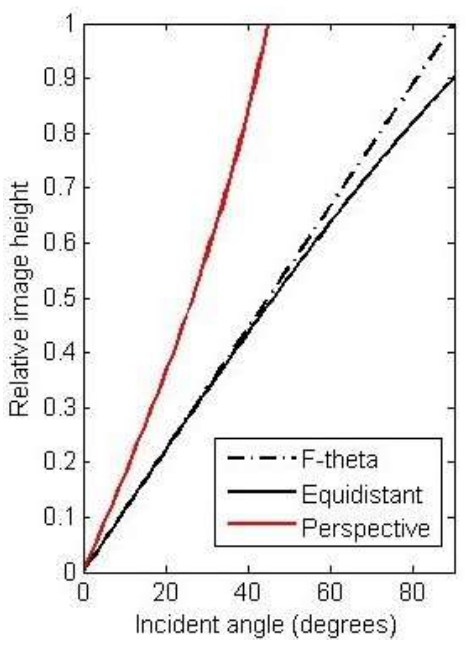
Figure 3. Plot of common projections used in optical systems displayed as image height vs. field angle.